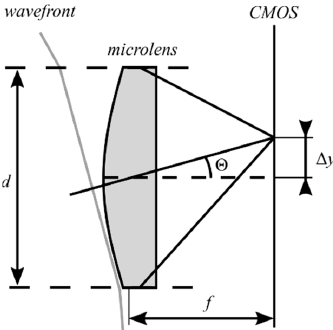
Figure 4. Position of the light spot in the microlens subaperture for a locally tilted wavefront. The maximum radius R ma x can be calculated from the condition of the minimum detectable angle θ min , it is determined by the Equation (15)